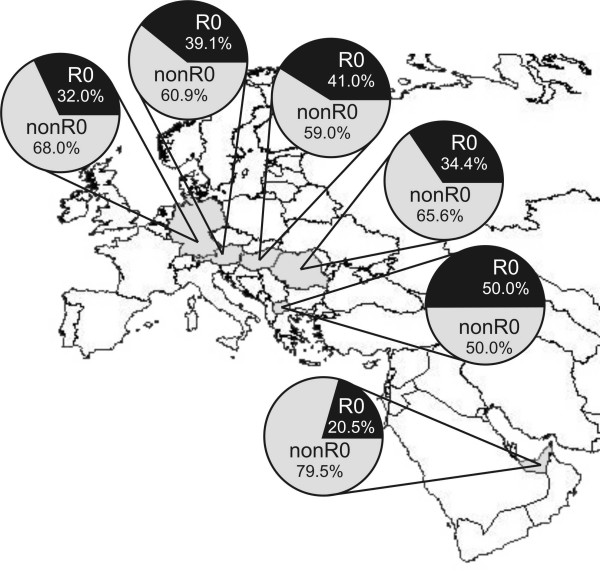
Distribution of mitochondrial hg R0 in population samples from Germany, Austria, Hungary, Romania, Macedonia and the Dubai (shown clockwise).